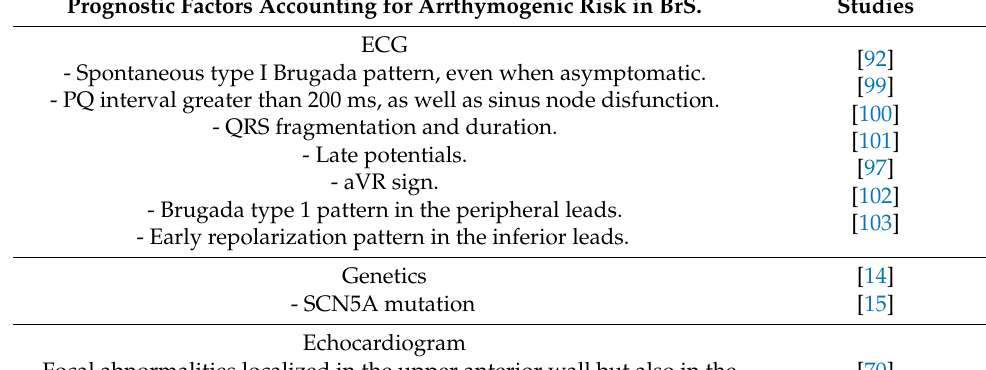
Table 3. Known and candidate prognostic factors for Brugada syndrome. Prognostic Factors Accounting for Arrthymogenic Risk in BrS. Studies